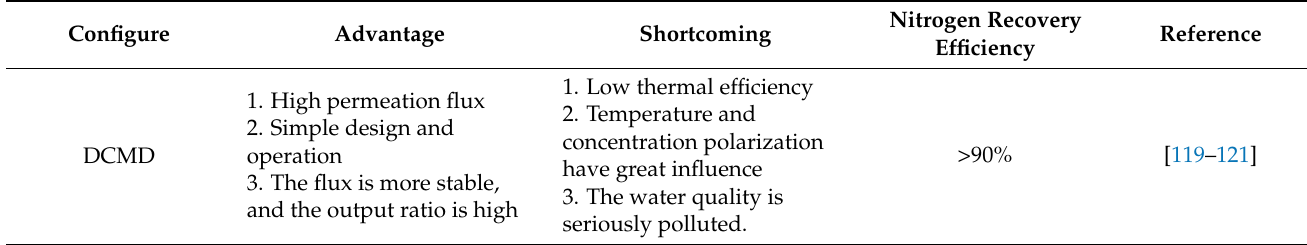
Table 4. Advantages and disadvantages of various types of membrane